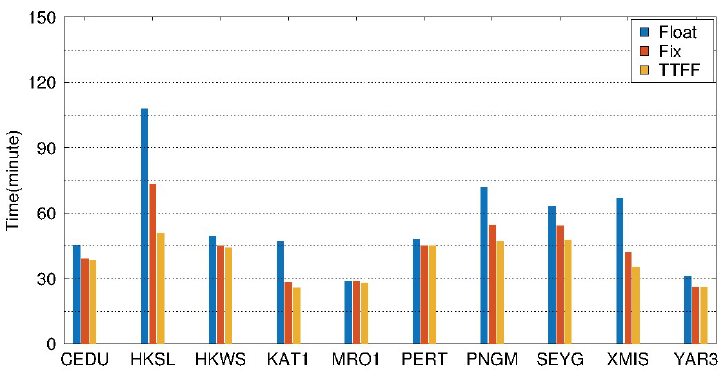
Figure 20. Average convergence time of float and fixed solutions, and TTFFs of 10 selected stations in static PPP processing from DOY 061 to 090, 2018. Table 5. The average accuracy of BDS static PPP for 10 stations (Unit: cm).